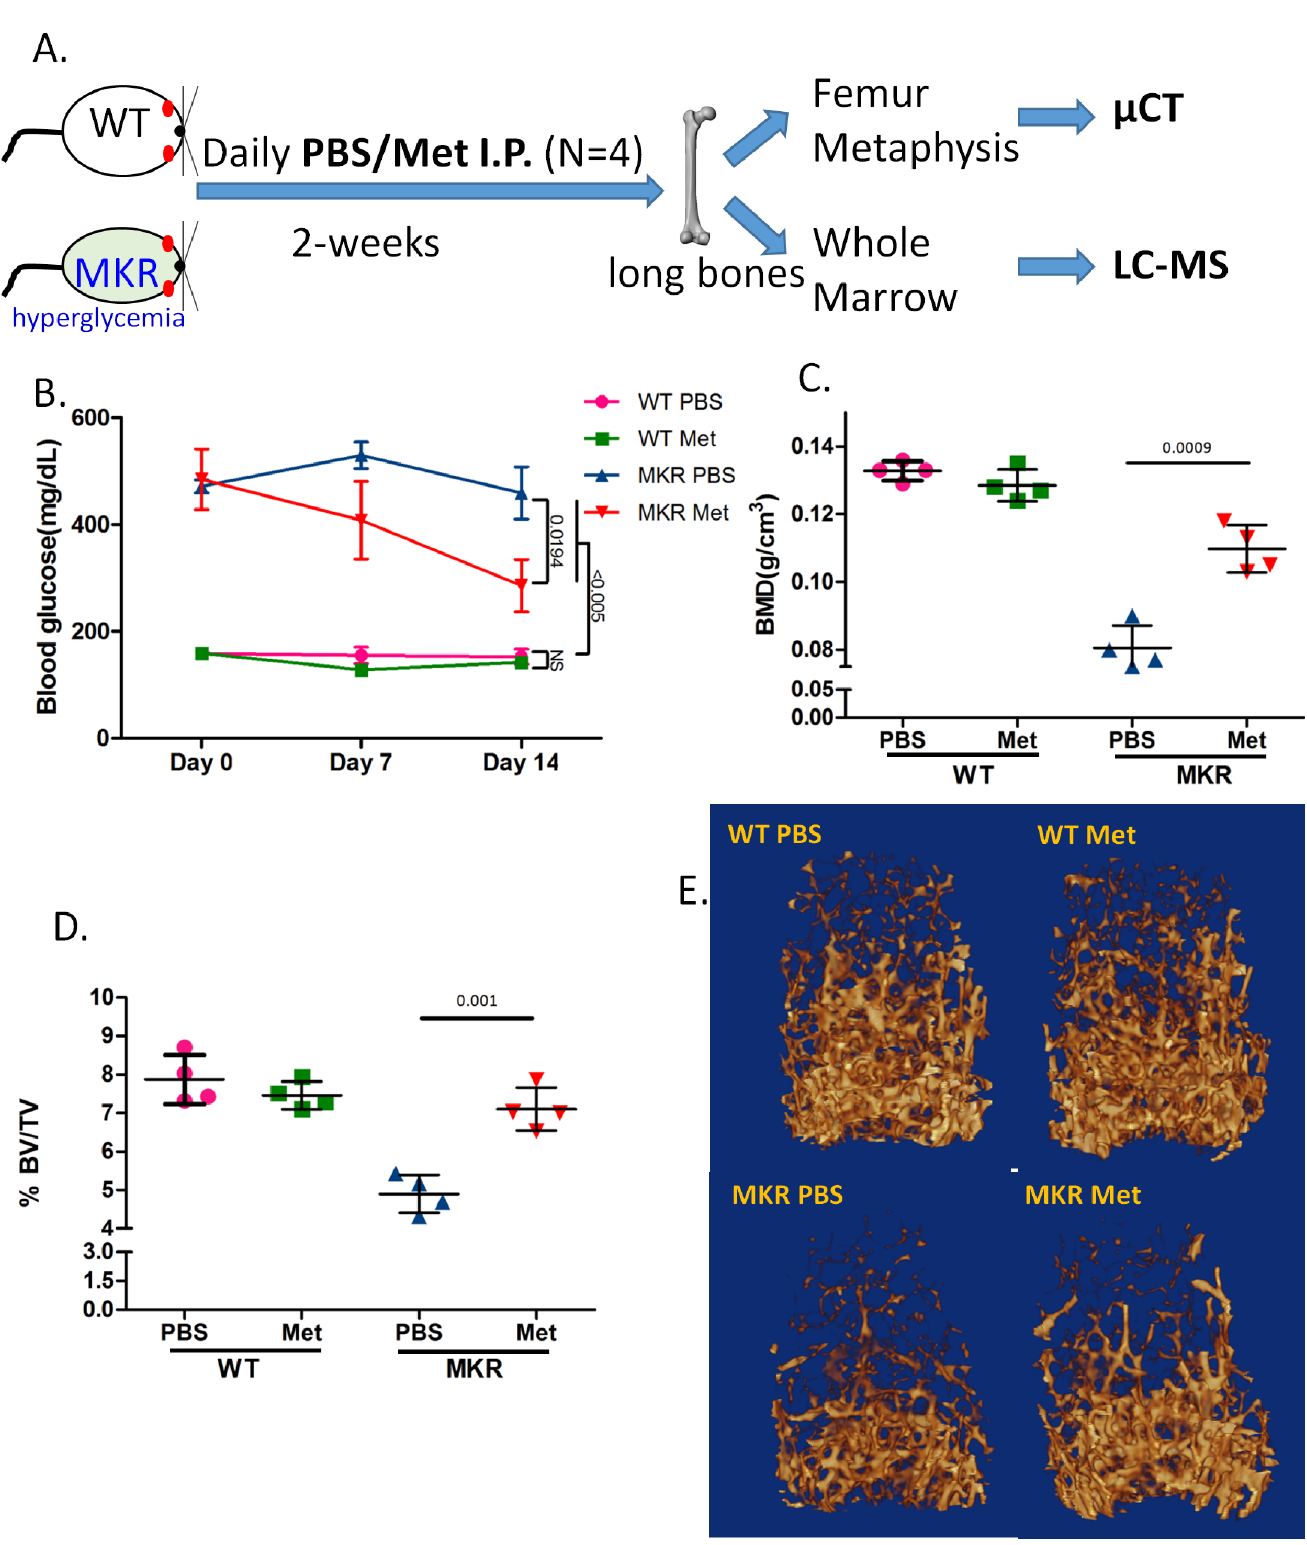
Fig 1. Metformin protected bone loss in hyperglycemic mice. A. Scheme of the experimental design in which 12-week-old male wild type (WT) and hyperglycemic (MKR) mice were treated with vehicle (PBS) or metformin intraperitoneally daily for 2-weeks. Long bones from both side hind limbs were